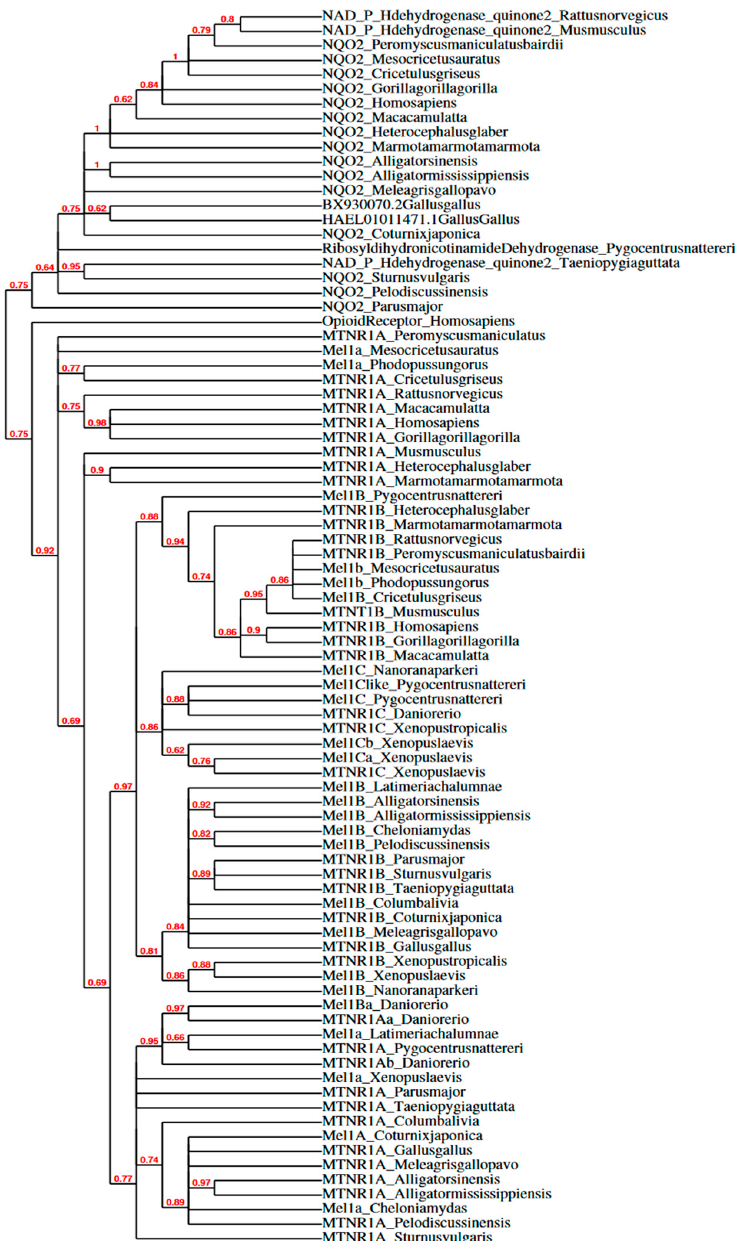
Figure 4. Cladogram of melatonin membrane receptor subtypes and quinone reductase 2. Modified from neighbor-joining tree (without distance corrections), generated by Phylogeny.fr (Dereeper et al., 2008 & 2010). Red numbers represent branch support values. Branch support values smaller than 50% are collapsed. The quinone family is named NAD(P)H dehydrogenase quinone 2, ribosyldihydronicotinamide dehydrogenase, or NQO2, based on how it is named in the NCBI database. Opioid Receptor for Homo sapiens (NCBI Accession No. L29301.1) served as the outgroup. NCBI Accession Numbers and full names of sequences are in Figure 4. The mRNA sequences of non-mammalian vertebrates ( nmv ) Mel1A diverged more recently than mammalian ( m ) Mel1B from mMel1A . The pharmacological evidence that Mel1A/MT1 in birds has one order of magnitude lower affinity for 2-[ 125 I]iodomelatonin than MT1 in some mammals (rabbit, sheep and horse) and one order of magnitude higher than MT2 other mammals (Syrian and Siberian hamsters) supports the phylogenetic evidence presented here that avian Mel1A mRNA is not evolutionarily homologous with mammalian Mel1A/MT1